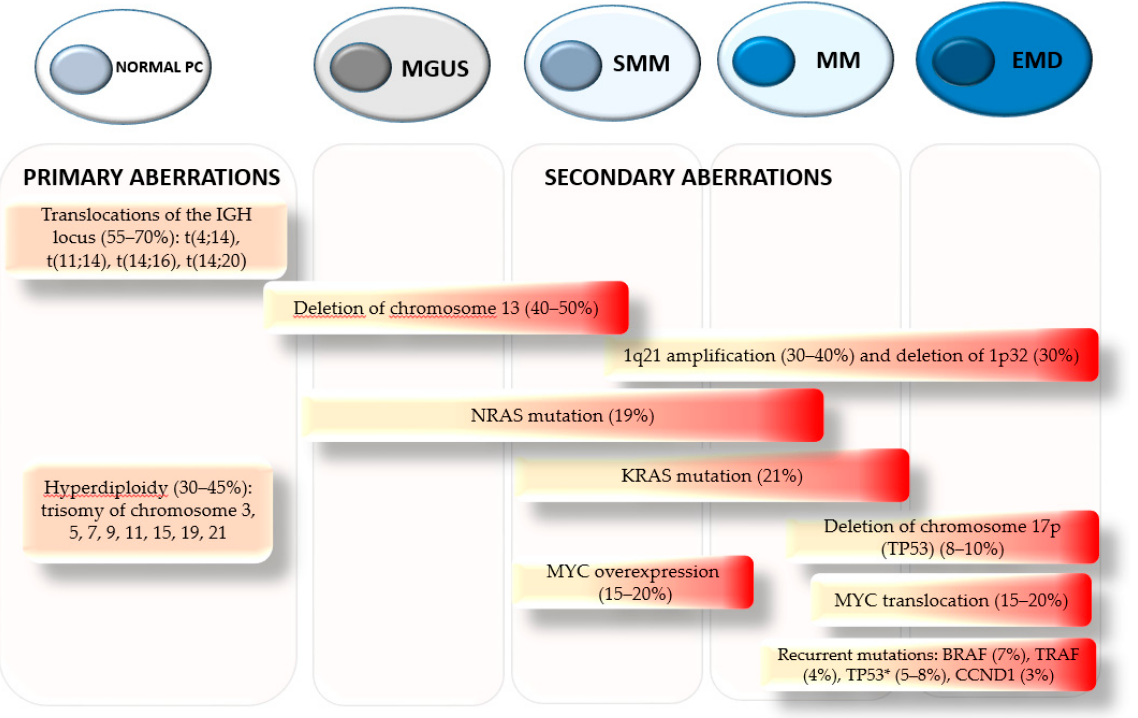
Figure 1. Genetic events from initiation to progression in multiple myeloma pathogenesis. Chromosomal aberrations involving immunoglobulin heavy chain ( IGH ) at the 14q32 region and the hyperdiploid are considered primary translocations as they are mutually exclusive and present in asymptomatic stages. Secondary aberrations follow primary events contributing to tumor progression and relapse. Secondary events cooperate with primary events to produce the malignant PC phenotype. The progression from MGUS-SMM to MM is associated with RAS mutation, MYC overexpression, and amplification of 1q21. Incidence of MYC translocation, deletion of 17p, and recurrent mutations increased as disease progressed. The initiation of aberrant clones at the onset of the disease is indicated in yellow. Red indicates the accumulation of malignant clones during disease progression. Percentage is indicated at new diagnosis. Asterisk indicates P53 mutation.